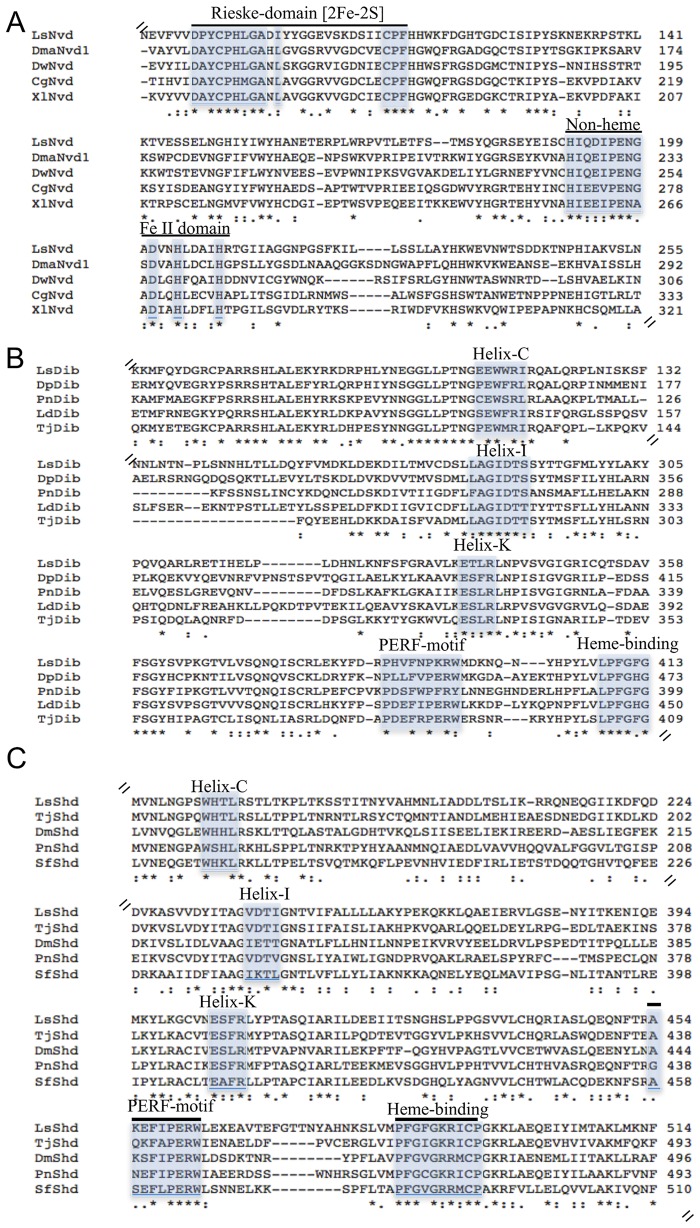
Alignment of deduced amino acid (aa) sequences of Lepeophtheirus salmonis 7,8-dehydrodenase/Neverland (LsNvd) (A), disembodied (LsDib) (B), and shade (LsShd) (C) with other species.A) The conserved Rieske motif and the non-heme domain are market off in the alignment. The sequences used in the alignments were as follows; L. salmonis Neverland (LsNvd; MF 598470), Daphnia magna Neverland subtype 1 (DmaNvd1; BAQ02388.1), Daphnia wassermani Neverland (DwNvd; AFD97360.1), Crassostrea gigas Neverland (CgNvd; XP_011445555.1), Xenopus laevis Neverland (XlNvd; BAK39959.1). B) Conserved P450 motifs are shown. The sequences used in the alignments were as follows; L. salmonis disembodied (Lsdib; ACO13011.1), Daphnia pulex Disembodied (DpDib; EFX63066.1), Paracyclopina nana CYP 302A1 (PnDib; AKH03533.1), Leptinotarsa decemlineata CYP 302A1 (LdDib; AGT57842.1), Tigriopus japonicus CYP 302A1 (TjDib; AIL94171.1). C) Conserved P450 motifs are shown. The sequences used in the alignments were as follows; L. salmonis Shade (LsShd; MF598469), Tigriopus japonicus Shade (TjShd; AIL94172.1), Daphnia magna Shade (DmShd; BAF35770.1), Paracyclopina nana Shade (PaShd; AKH03534.1) and Sogatella furcifera Shade (SfShd; AGI92296.1).